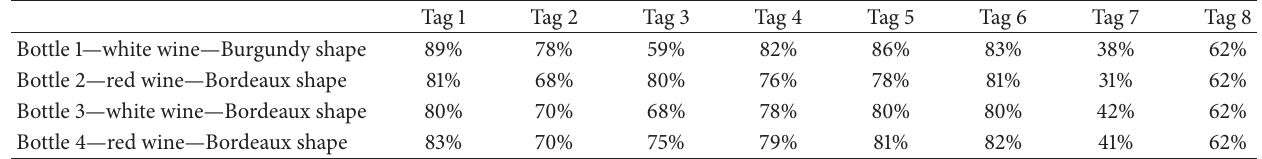
Table 4: Percentage of reduction in the maximum received power due to the influence of wine.